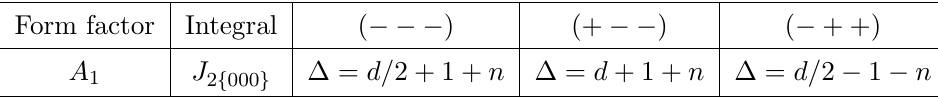
O I 2 O I 3 i , with (cid:1) 2 = (cid:1) 3 = (cid:1). 1 (cid:23) 2